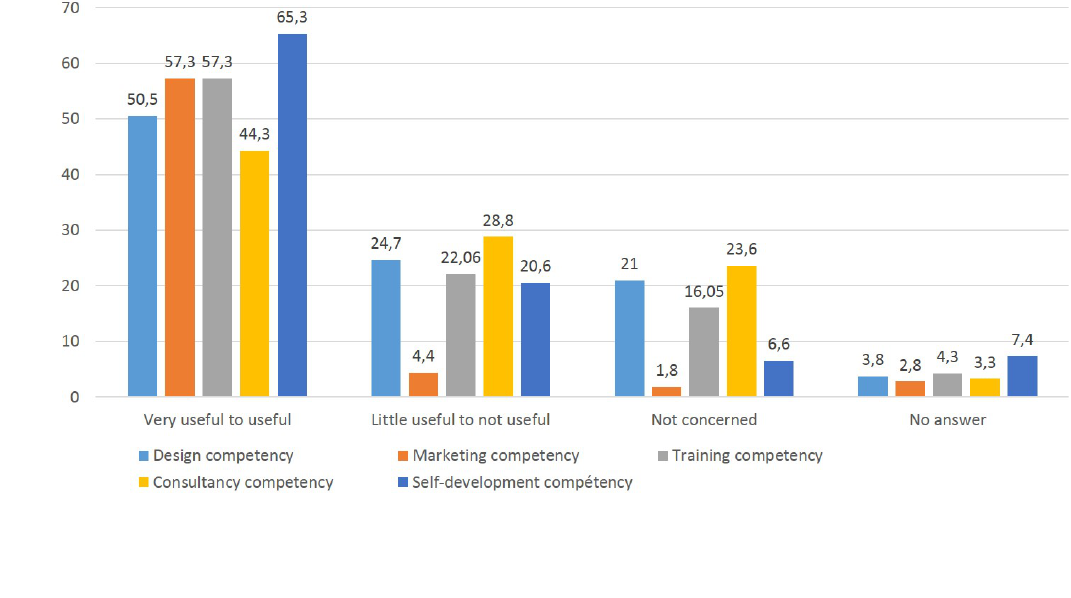
Figure 4 : Self-evaluation of utility degree of each core competency by the respondents The degree of utility of these competencies for professional life is considered for 40 % at 66 % of respondents ‘to be very useful to useful’. The presence of training needs, inferred from crossing these two evaluations, is more sensitive for commercial and training design competencies than for the segment of competencies in training facilitating and in consultancy. Finally, a strong concern for the development of activity and own continuous education and training is